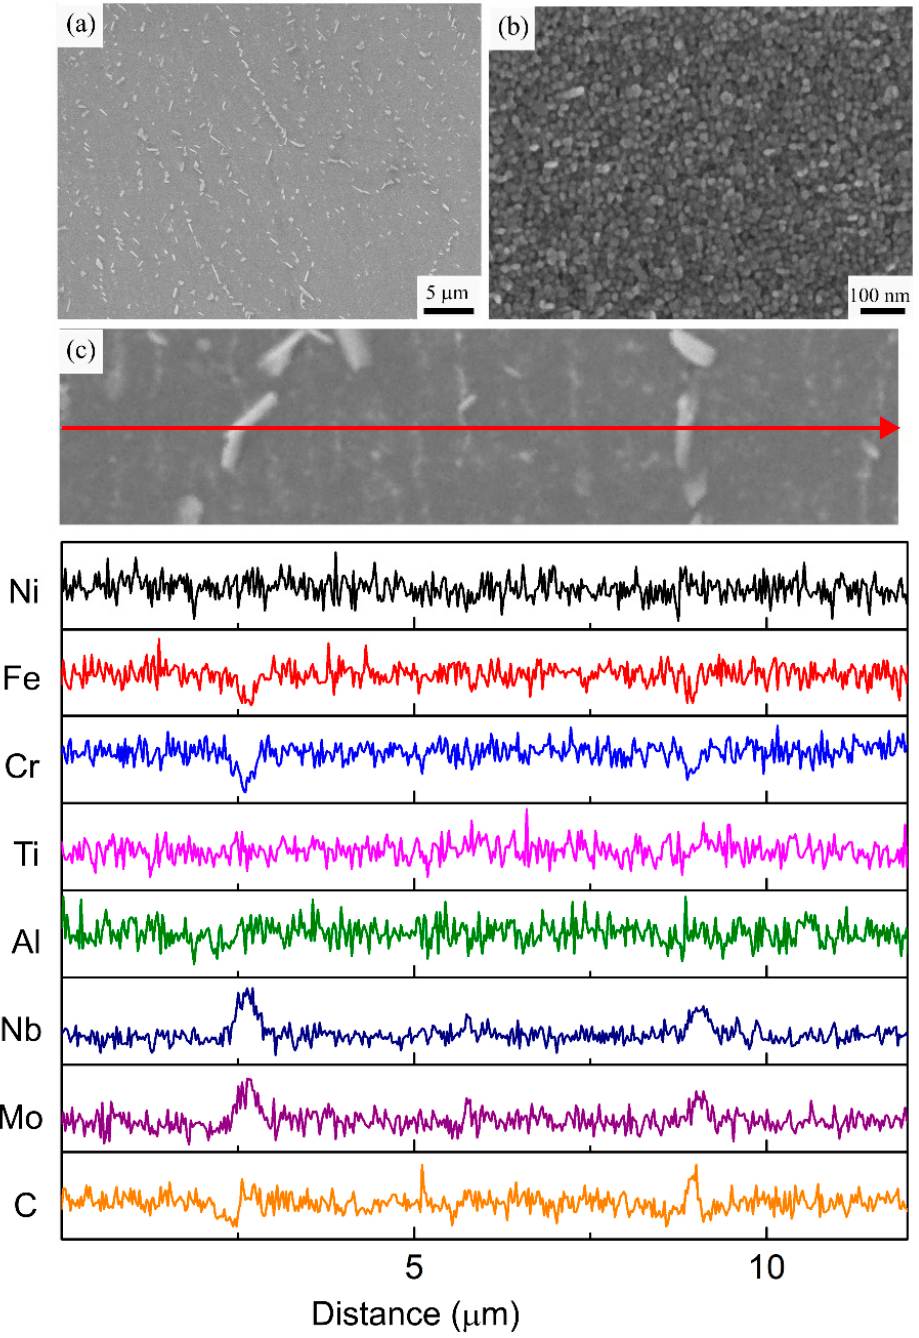
Figure 8. ( a , b ) Representative SEM micrographs, ( c ) EDS line scan analysis of the HT1 specimen along the marked red